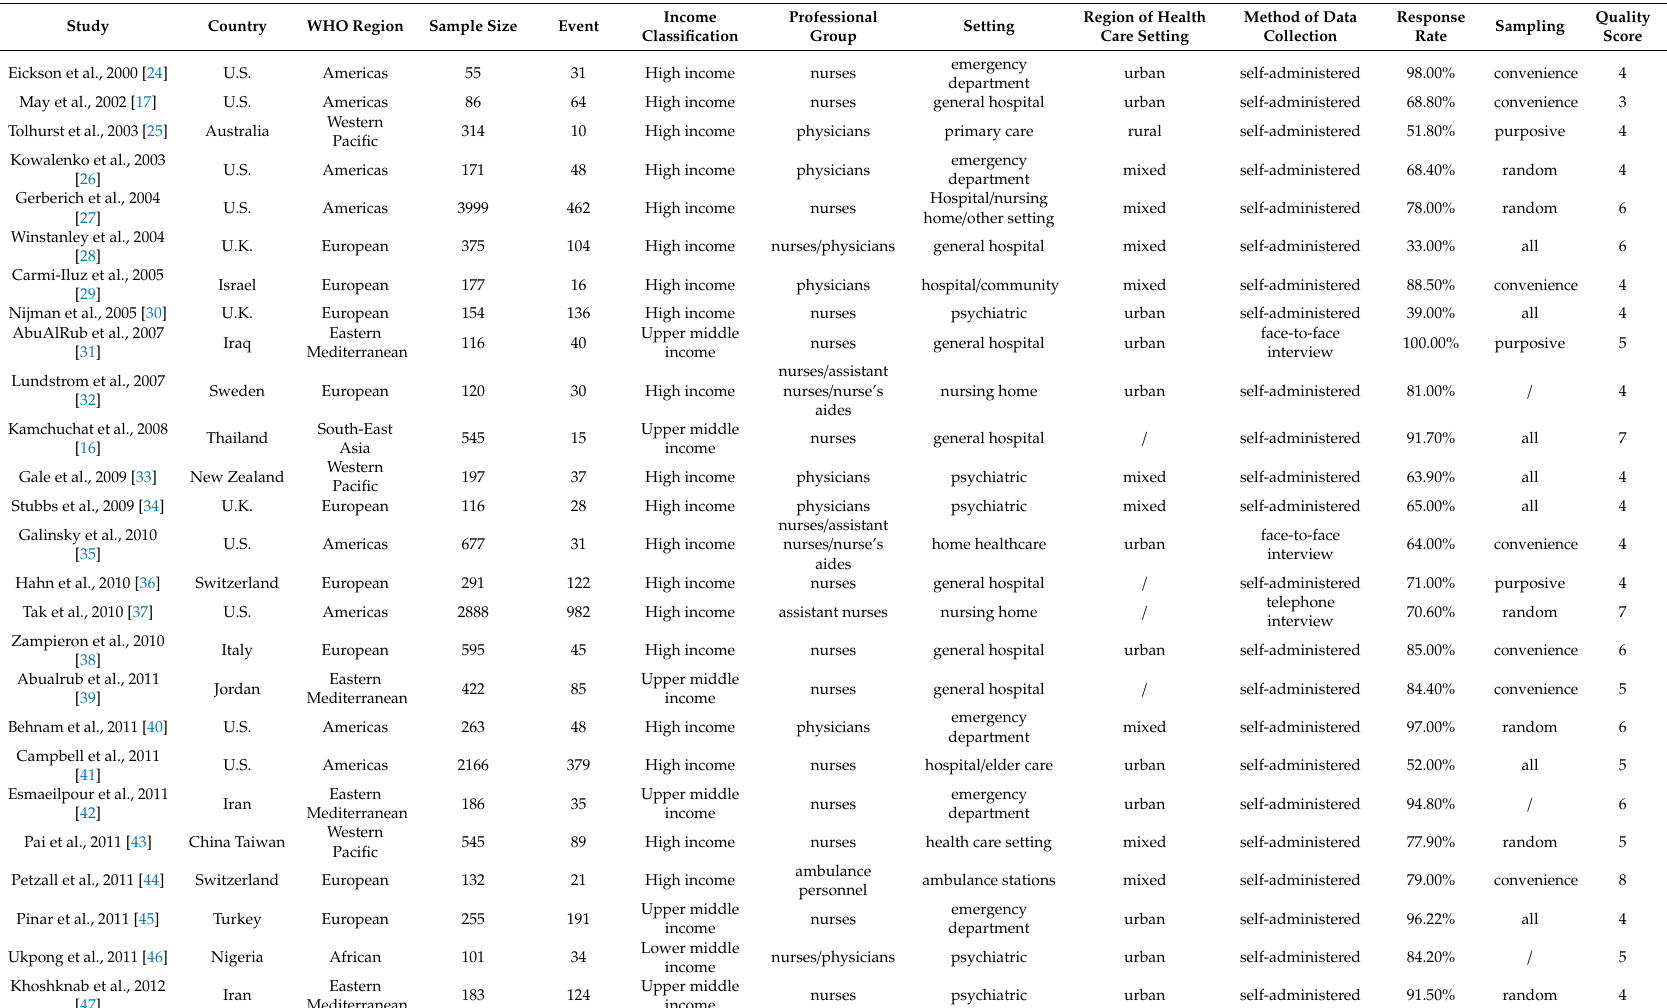
Table 1. Characteristics of prevalence studies included in meta-analysis. WHO, World Health